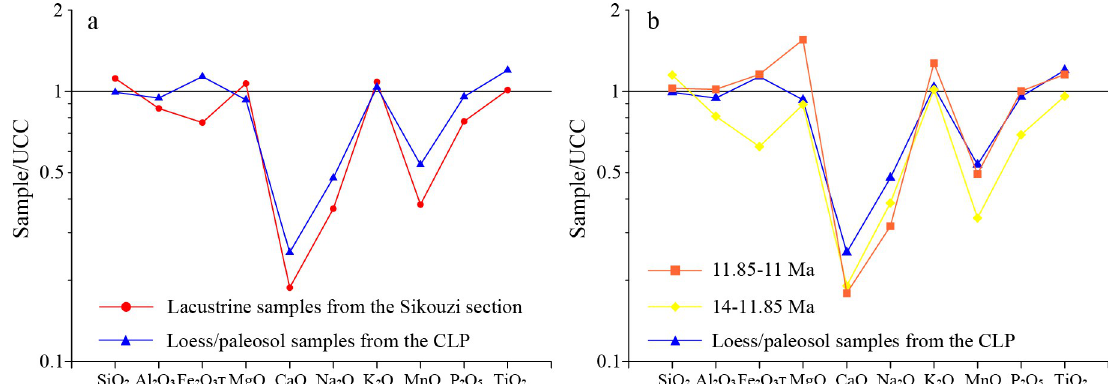
Fig 4. UCC-normalized abundances of major elements for the fluviolacustrine fine samples of the Sikouzi section and for the Baishui samples of loess-soil in the CLP [28]. The UCC values denote Upper Continental Crust compositions from Taylor and McLennan [31] and McLennan [32]. a, all samples; b, two time